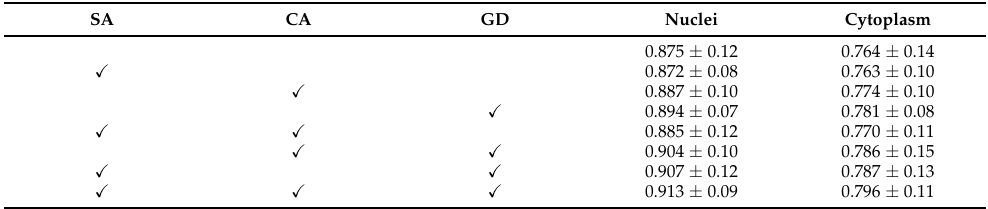
Figure 7. Visual results of disassembling the GDLA module. Table 4. Disassembling GDLA module. The effects of the three components of the GDLA network on the network performance. The values are in the format of µ ± σ